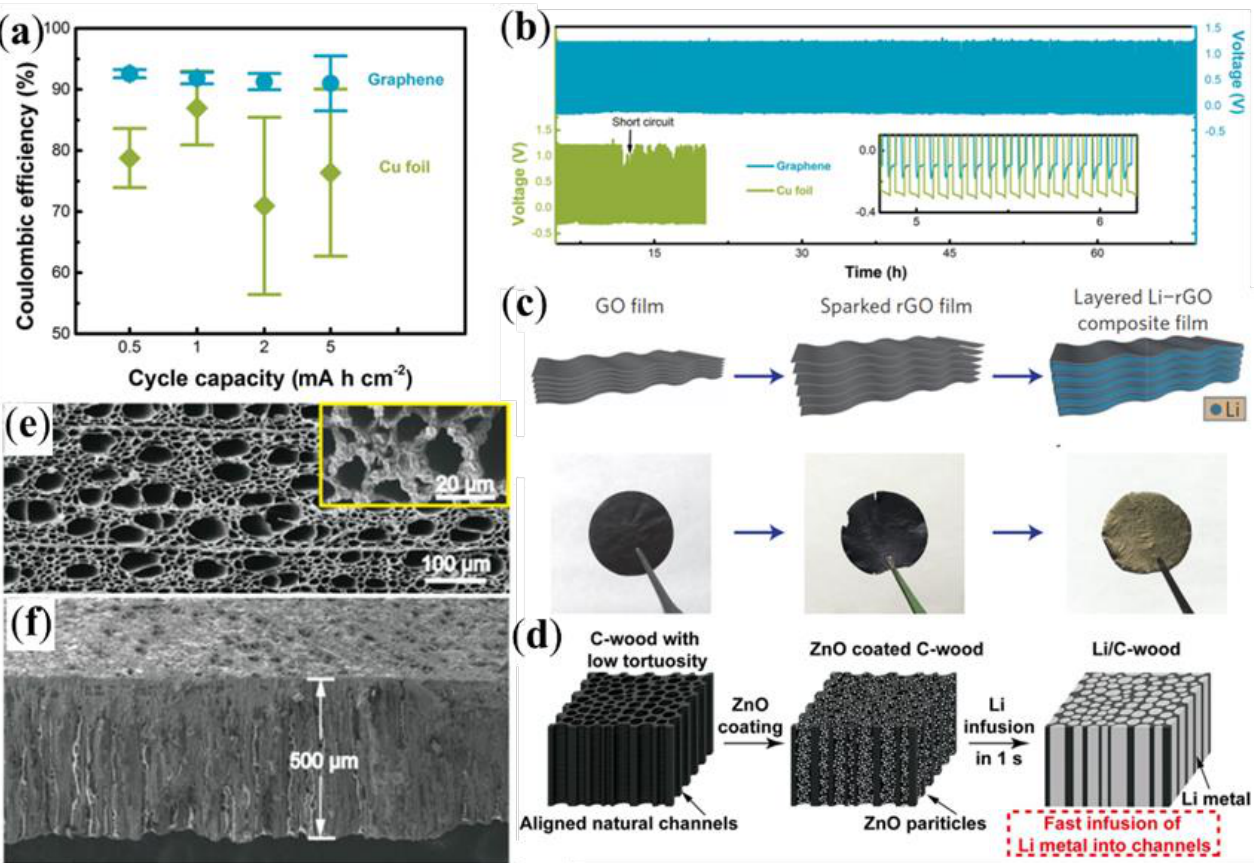
Figure 6. ( a ) Average CE and its variance for Cu foil and graphene-based anode with various cycling capacities at 0.5 mA cm −2 ; ( b ) Voltage profiles for graphene- and Cu foil-based anode in 800 cycles at 2.0 mA cm −2 , fixing capacity at 0.1 mA h cm −2 [78]. Copyrights © 2022, WILEY-VCH. ( c ) Synthesis process from GO film (left) to a sparked rGO film (middle) to a layered Li – rGO composite film (right) with the corresponding digital photos [79]. Copyrights © 2022, Macmillan Publishers Lim- ited. ( d ) The synthesis process of Li/C-wood composite; ( e ) Top-view SEM images of ZnO-coated C-wood; ( f ) Cross-sectional SEM images of Li infusion in the channel void space [80]. Copyrights © 2022, Macmillan Publishers Limited.